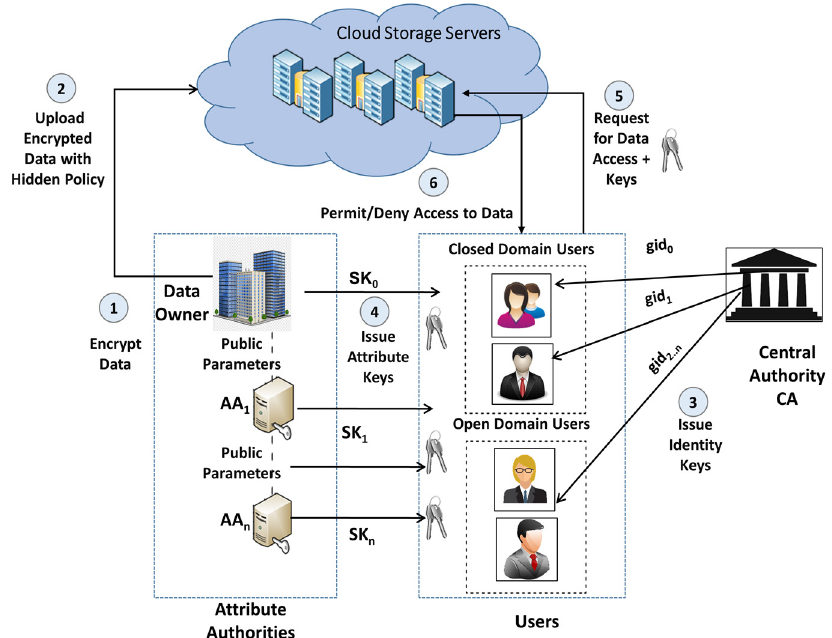
Figure 2. System model for SP-MAACS scheme .